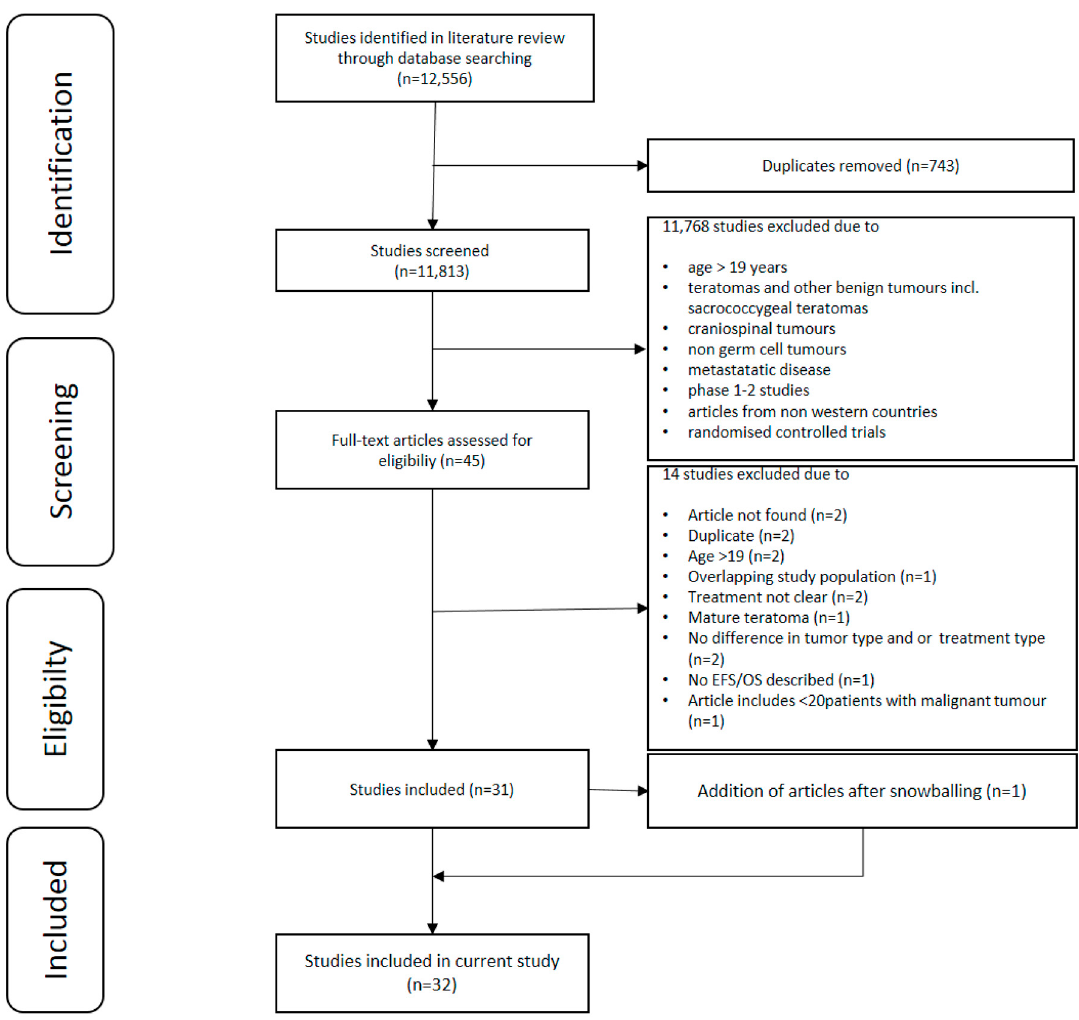
Figure 2. The selection process, based on the PRISMA schema.